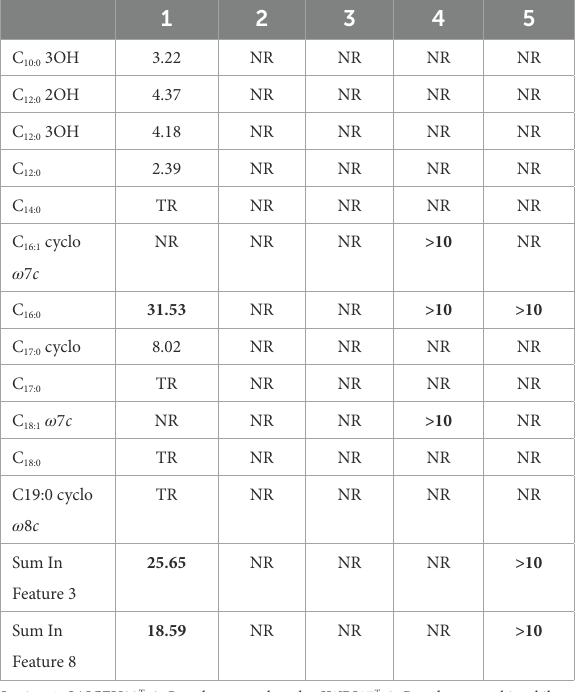
TABLE 10 Cellular fatty acid profiles (> 1%) of strain SAICEU22 T and type strains of closely related species.